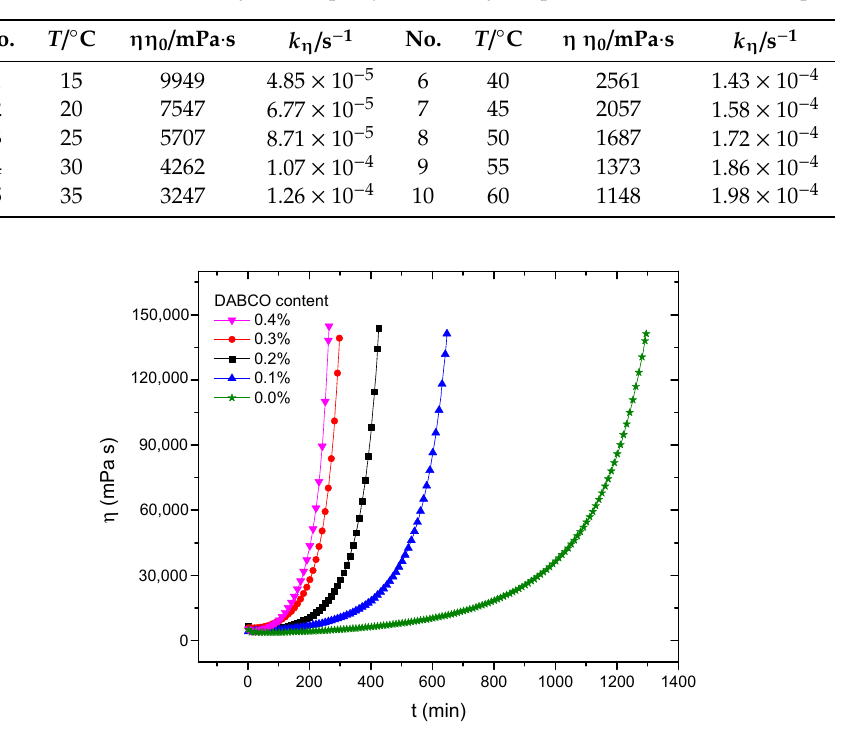
Figure 5. Viscosity build-up of the HTPB/HDI-trimer cure reaction in different mass fractions of the DABCO.